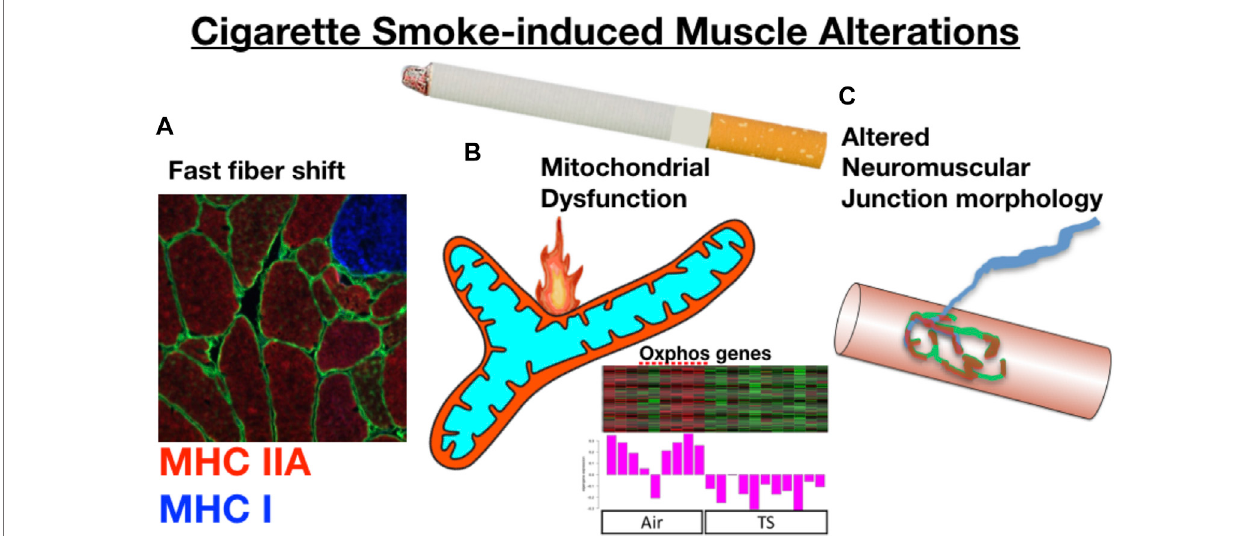
FIGURE5| Exposuretocigarettesmokeleadstoactivationofthearylhydrocarbonreceptor(AHR).UponcigarettesmokeconstituentbindingtotheAHR,theAHR translocates tothe nucleus and dissociates from its chaperonesbefore binding tothearyl hydrocarbonreceptor nucleartranslocase (Arnt) and then binding with theso- called DNA response element (or xenobiotic response element) of target genes to up-regulate the expression of detoxifying cytochrome P450 enzymes (e.g., Cyp1A1). Notably,whereasacuteactivationoftheAHRisadaptive,chronicactivationleadstoROS-mediatedstressandmitochondrialdysfunctionthatleadstotoxicity.The legend de fi ning each of the components in this schematic is in the box to the right.